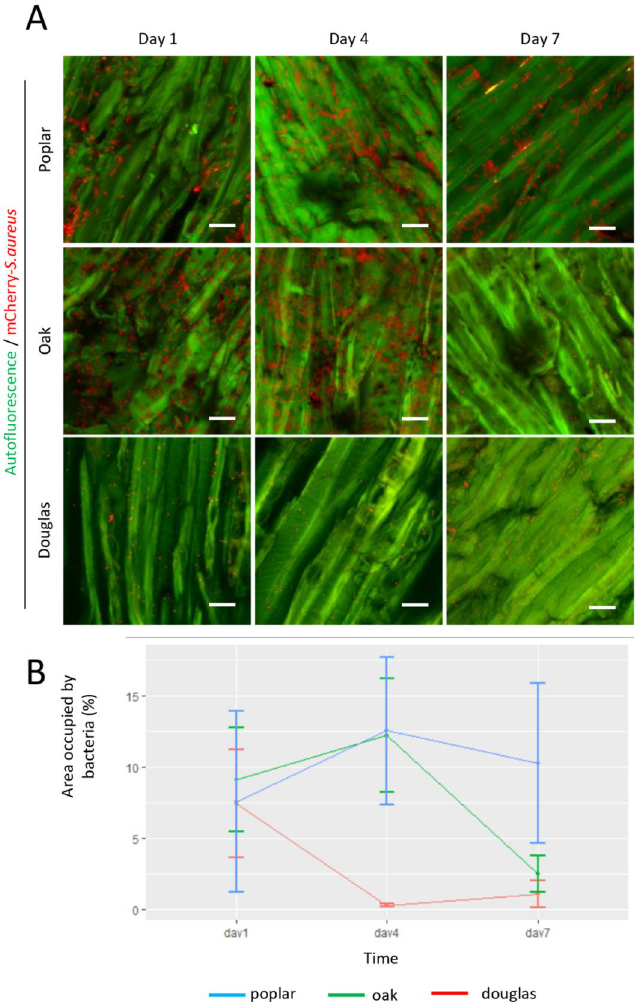
Figure 4. Evolution of mCherry— S. aureus bio-distribution on wood surfaces. (A) Confocal imaging of mCherry— S. aureus (red) on tangential sections of poplar (upper panel), oak (middle panel) and Douglas fir (lower panel) disc at 1-, 4- and 7-days after bacteria inoculation. Woods were observed thanks to their autofluorescence (green). Scale bar = 20 µm. (B) Quantification of the surface occupied by mCherry— S.aureus spots related to total area of woods. Interactions of time and wood on aera were evaluated by linear mixed effects models considering a random effect (R software, nlme package). Error bars represent SEM of the